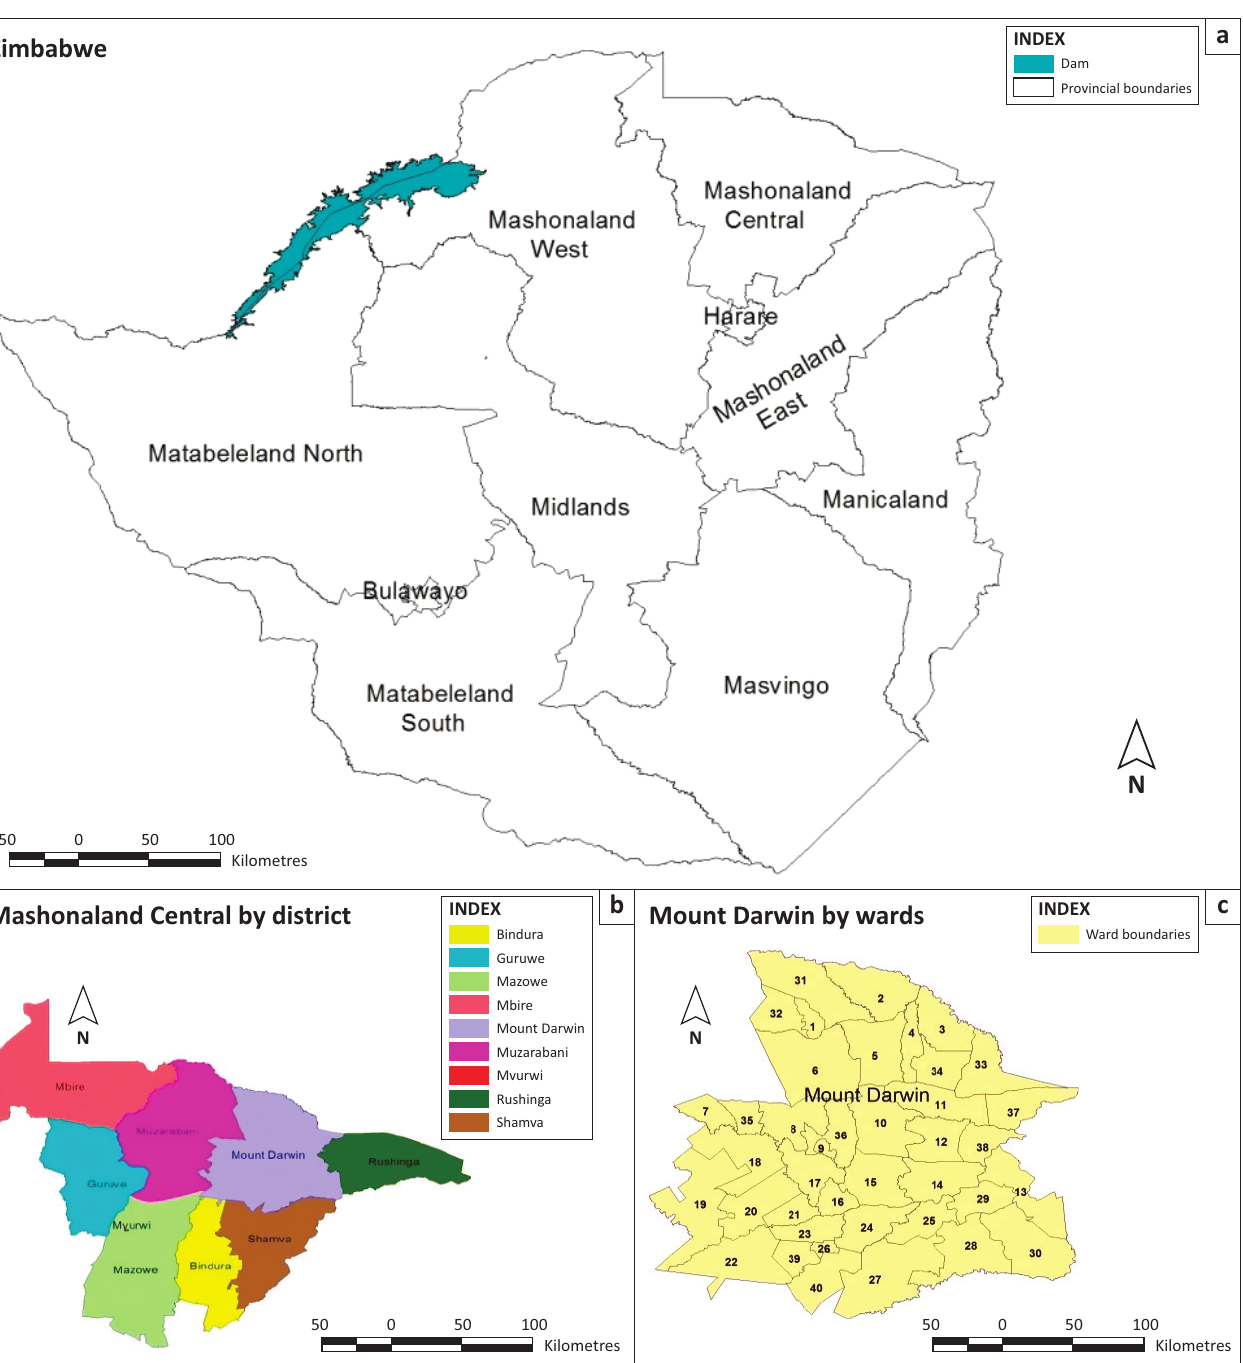
FIG URE 1: Maps for Zimbabwe, Mashonaland Central province and Mount Darwin